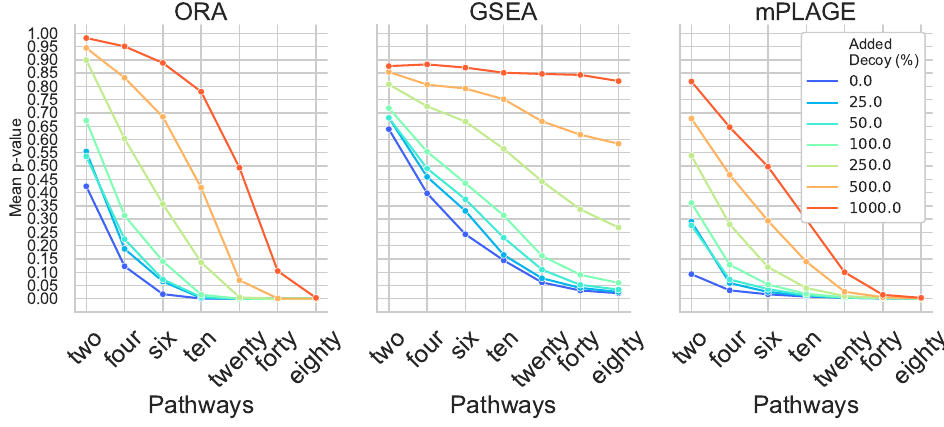
Figure 1. Adding nonchanging decoy features to the seven known changing pathways T = { 2,4,6,10,20,40,80 } . The percentage of decoy features represents the number of additional noisy features added to a pathway as a percentage of the original number of features in that pathway. The boxplots show the spread of the p -values calculated from the pathways, including the median (solid horizontal line). The red dashed line indicates a p -value threshold of 0.05. The results show that increasing noise levels generally produces higher p -values, making it harder to detect significantly changing pathways. mPLAGE is more robust compared to other methods in returning lower p -values in the presence of noise.